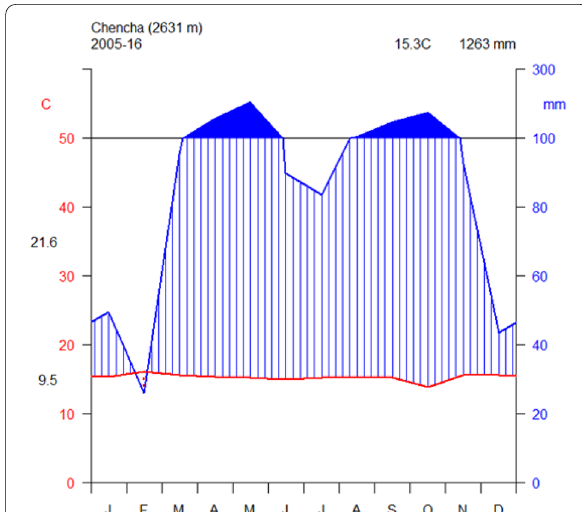
Fig. 2 Climate diagram showing the mean monthly rainfall and temperature distribution records of the study area taking 10 years (2007–2016) (Source: NMSA)